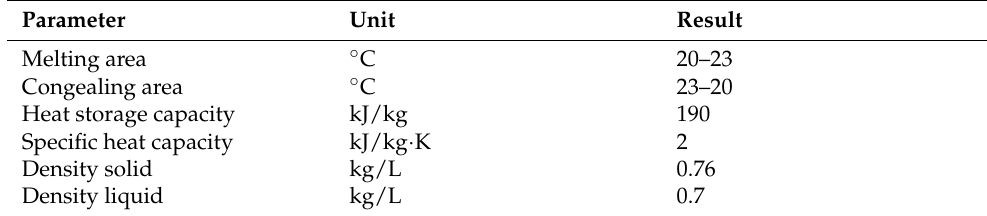
Table 1. Main parameters of Rubitherm RT 22HC